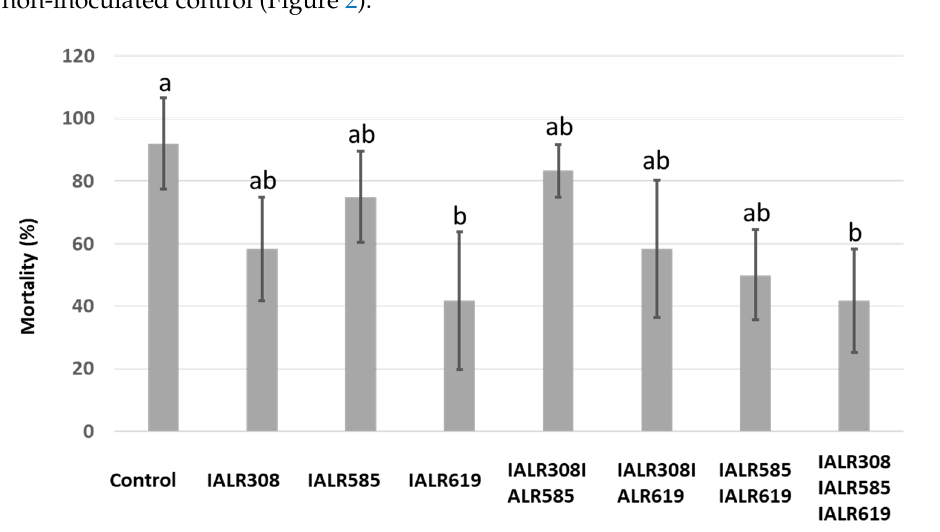
Figure 2. Effects of bacterial inoculation on average strawberry mortality in the greenhouse. Different letters on bars mean significantly different at p < 0.05. The Fisher’s LSD test was used for comparing differences between treatment means. Plug strawberry plants were inoculated with bacterial cultures on 20 September 2018 and infected with fungal pathogen on 3 October 2018. Final mortality was recorded on 31 January 2019.